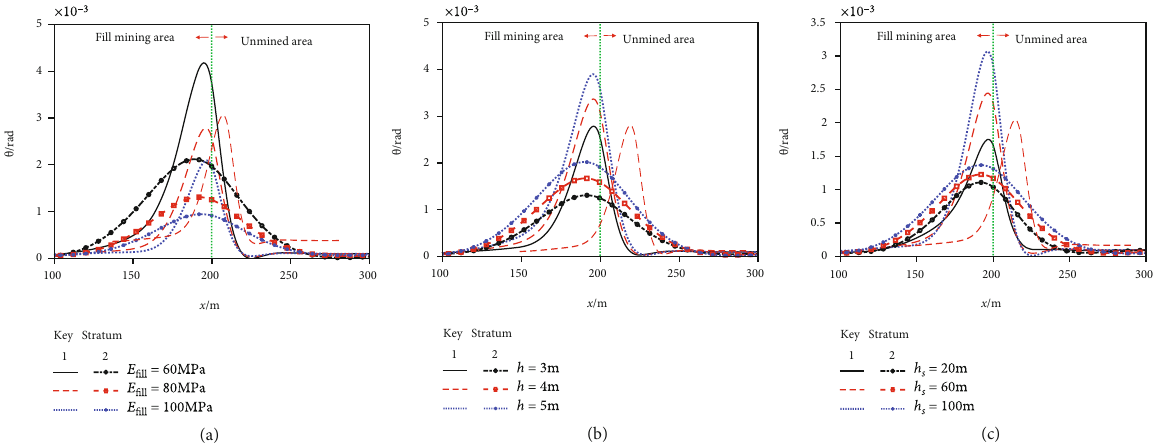
Figure 6: The curves of key strata rotating angle with the distance to the middle of the stope under various (a) elastic modulus of back fi ll, (b) mining height, and (c) thickness of soft layers.